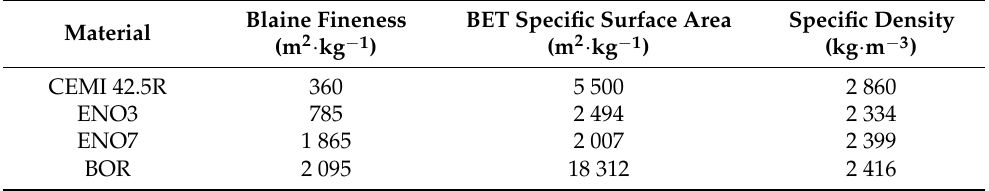
Table 6. Physical properties of cement and diatomaceous earth.